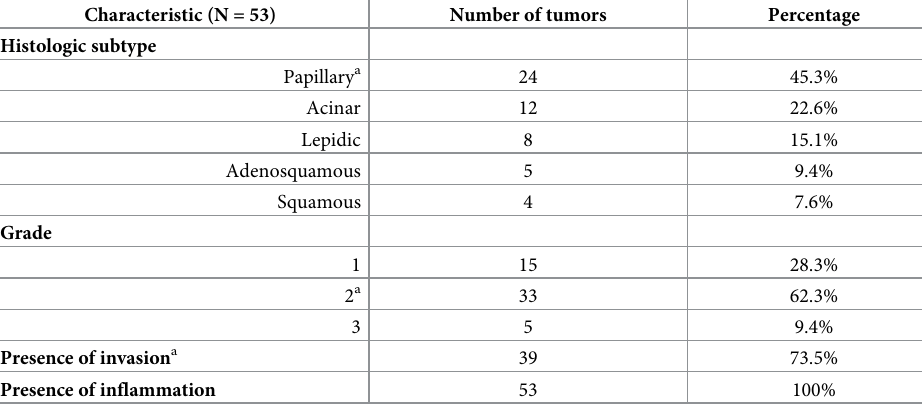
Table 3. Histopathology of 53 canine lung